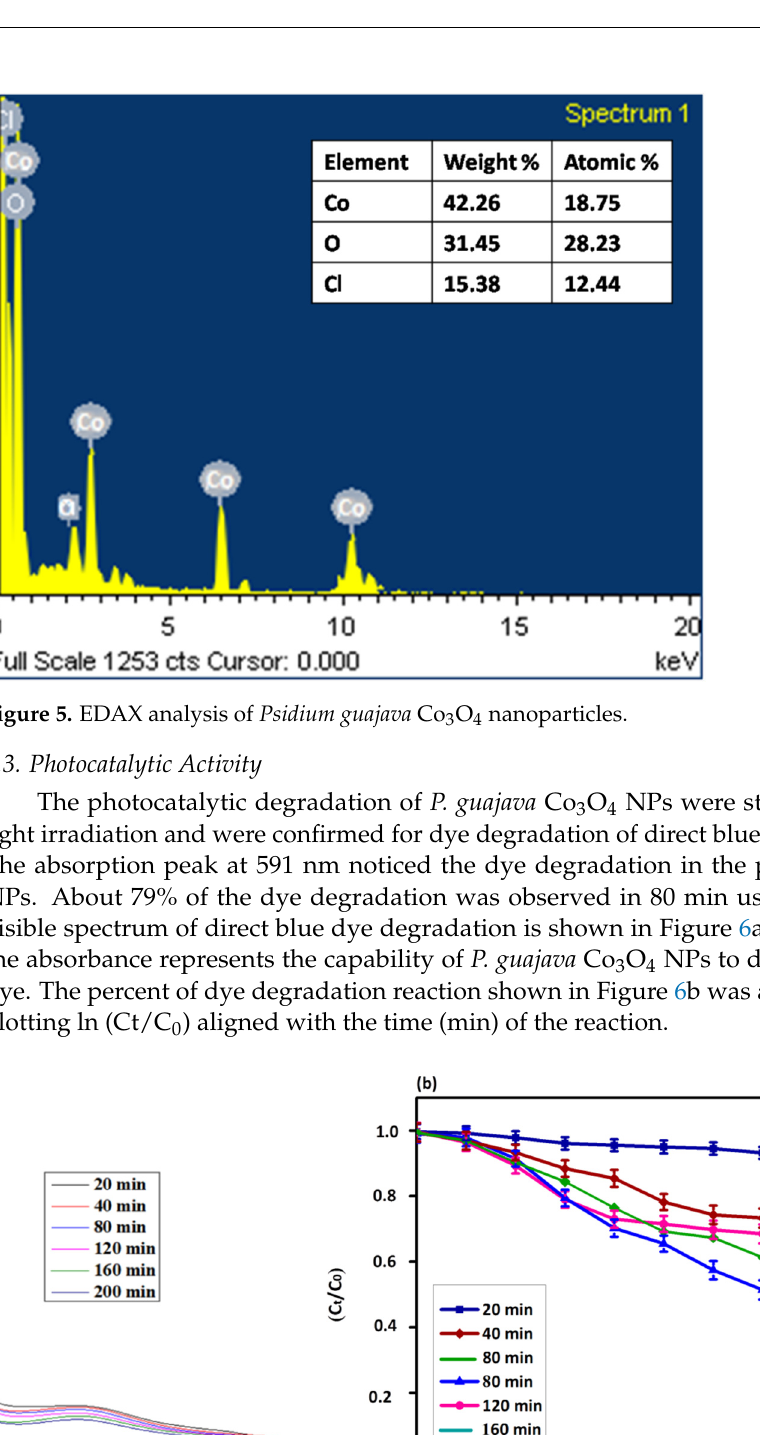
Figure 6. ( a ) UV-visible analysis ( b ) Dye degradation using Psidium guajava Co 3 O 4 NPs as a catalyst under solar light